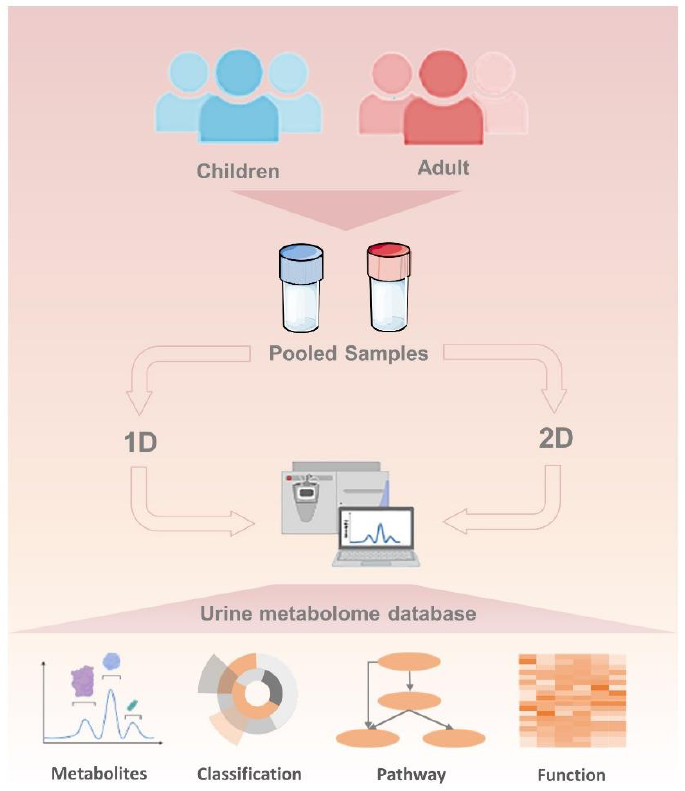
Figure 1. The workflow of this study: 1D means one-dimensional separation, and 2D means two- dimensional separation.